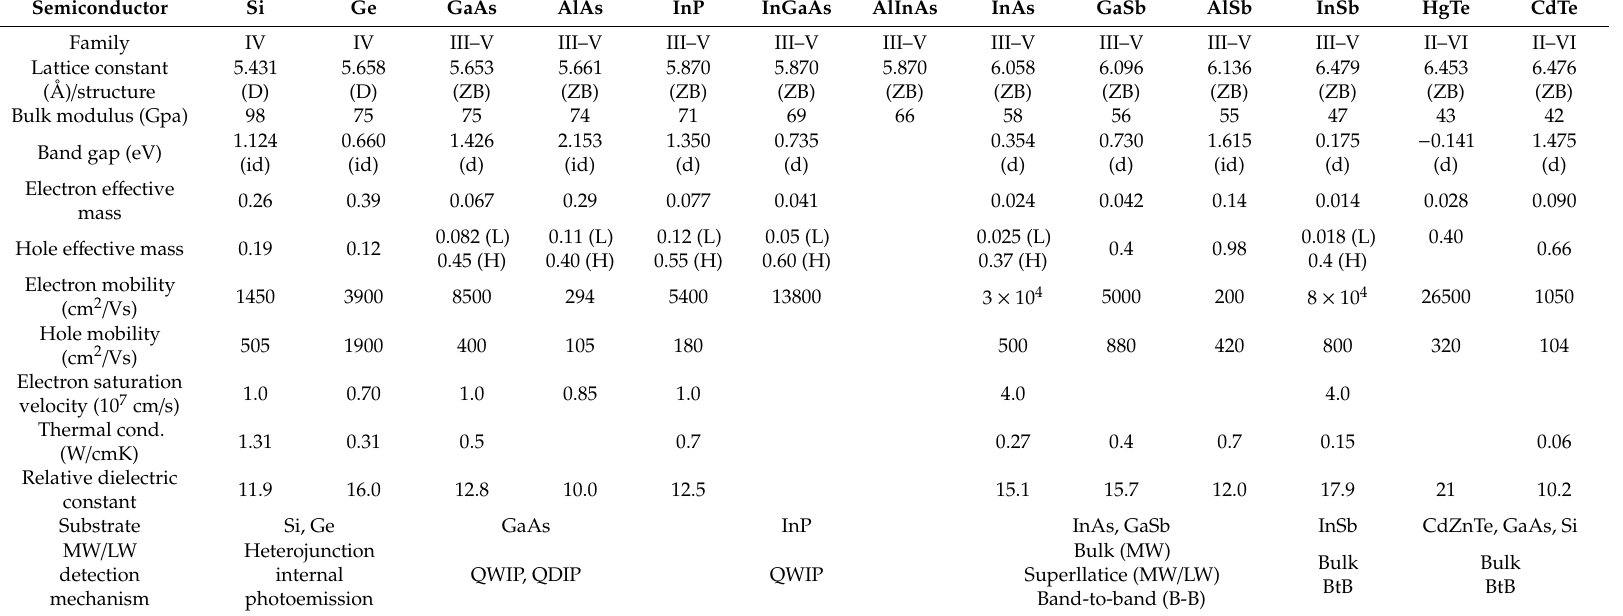
Table 2. Fundamental properties of semiconductors used in IR photodetectors